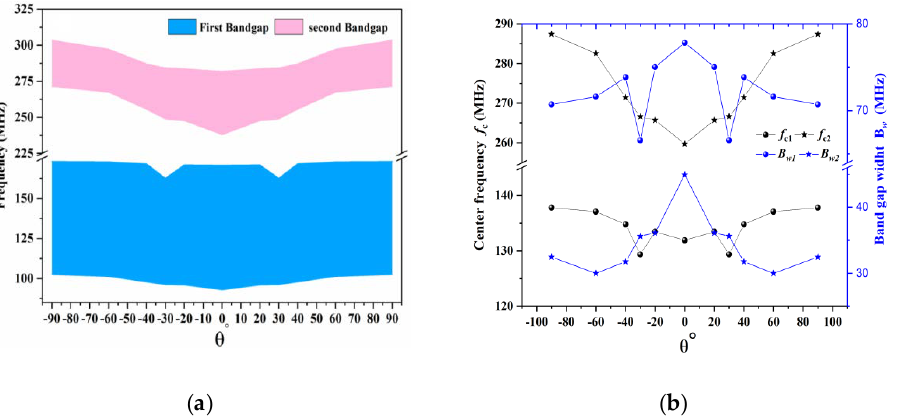
Figure 10. Evolution of ( a ) the bandgaps map, and ( b ) the center frequencies f c and bandgap widths B w of the first and second bandgaps with the angle θ of tilted w - Sc 0.375 Al 0.625 N based PnCs structure.